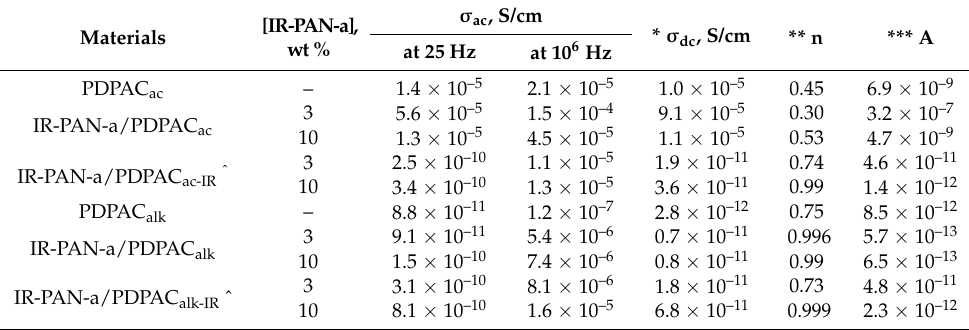
Table 3. The conductivity values of